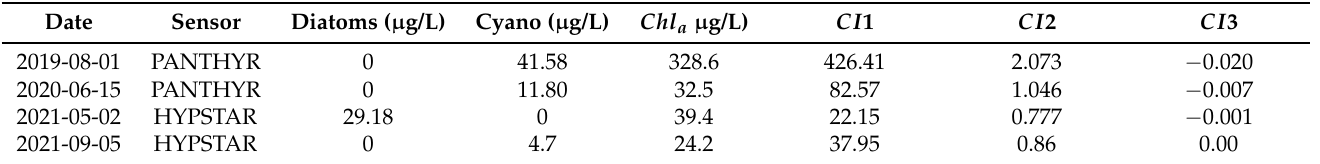
Table 3. Phytoplankton parameters measured in the Blankaart reservoir at the same date as water reflectance spectra displayed in Figure 9 and cyanobacteria indexes ( CI ) calculated from the water reflectance. See text for details about the different CI